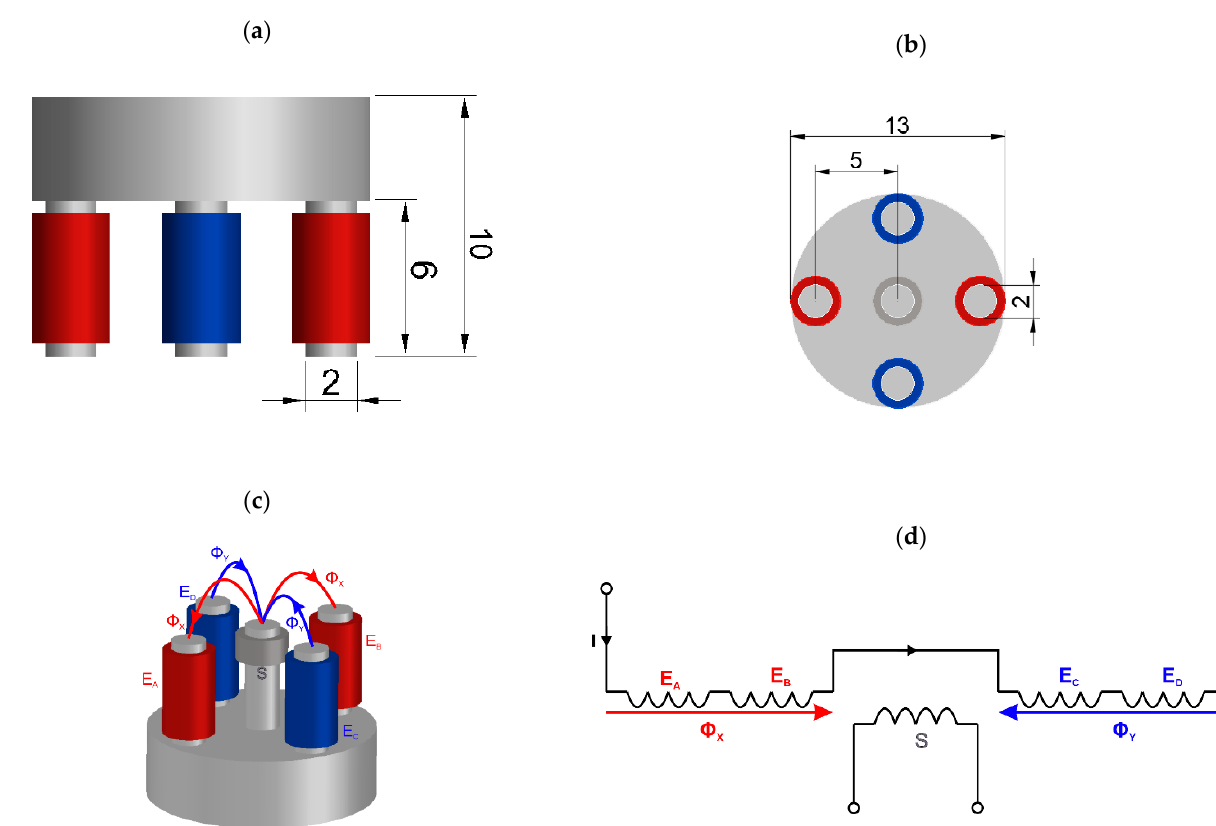
Figure 8. Views of the five columns of ECT transducer used in the experiments: ( a ) front view with dimensions, ( b ) bottom view with dimensions, ( c ) view with magnetic fluxes, the two groups of the excitation coils are marked with red and blue color, ( d ) the simplified electrical scheme of the probe. Table 1. Transducer